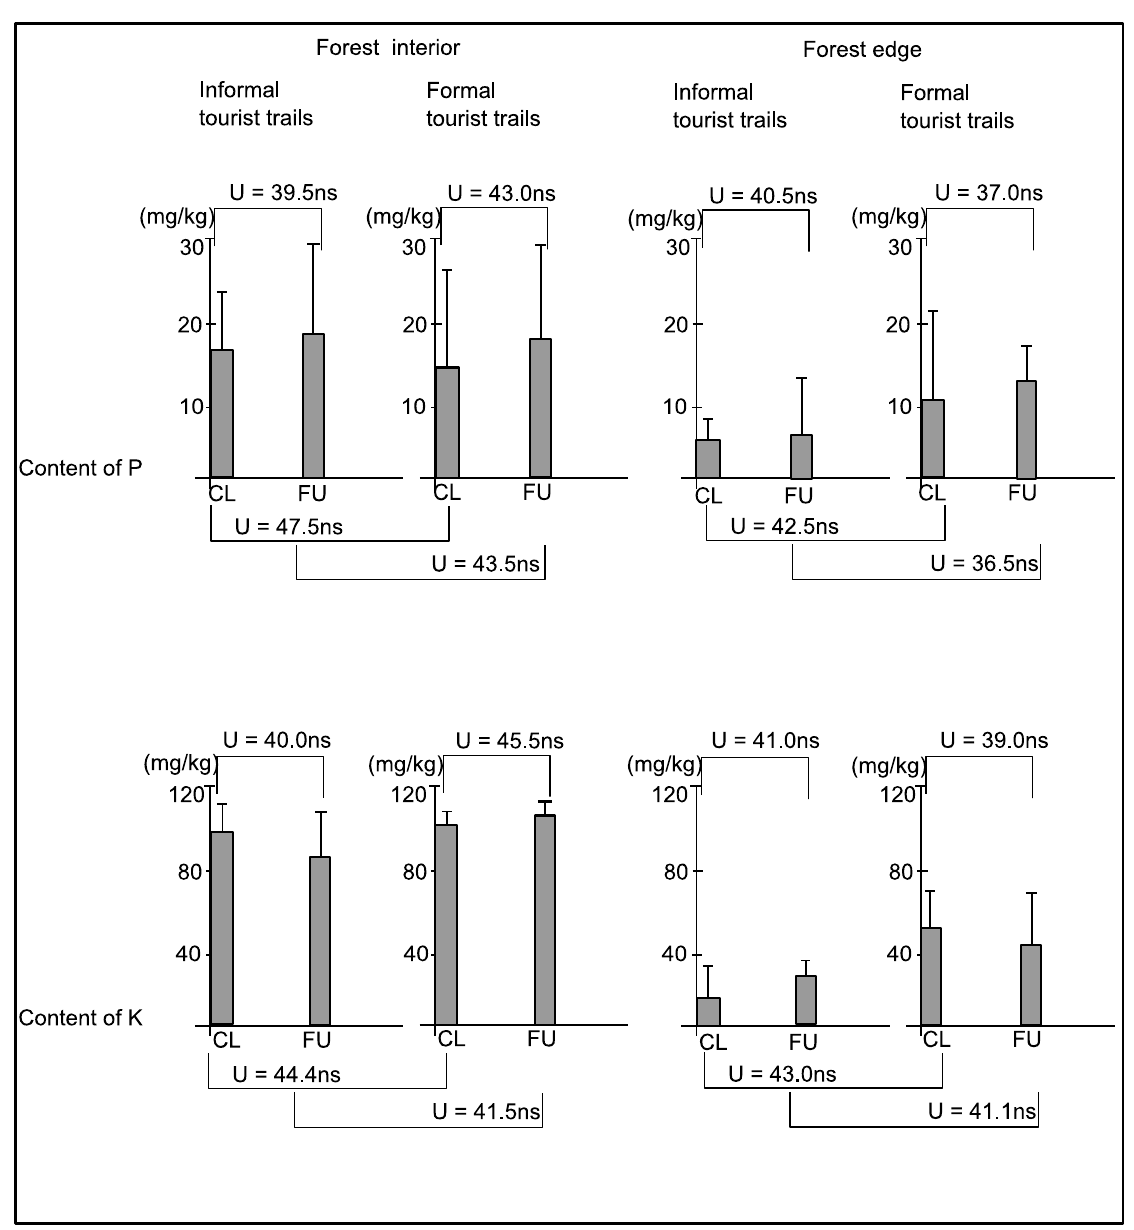
Figure 6. The mean content of phosphorus (±SD) and potassium (±SD) in soil samples of closer (CL) and further (FU) plots located along informal (width < 50 cm) and formal (width > 150 cm) tourist trails within the forest interior and forest edge sites. The statistical significance level is explained in Figure 2.